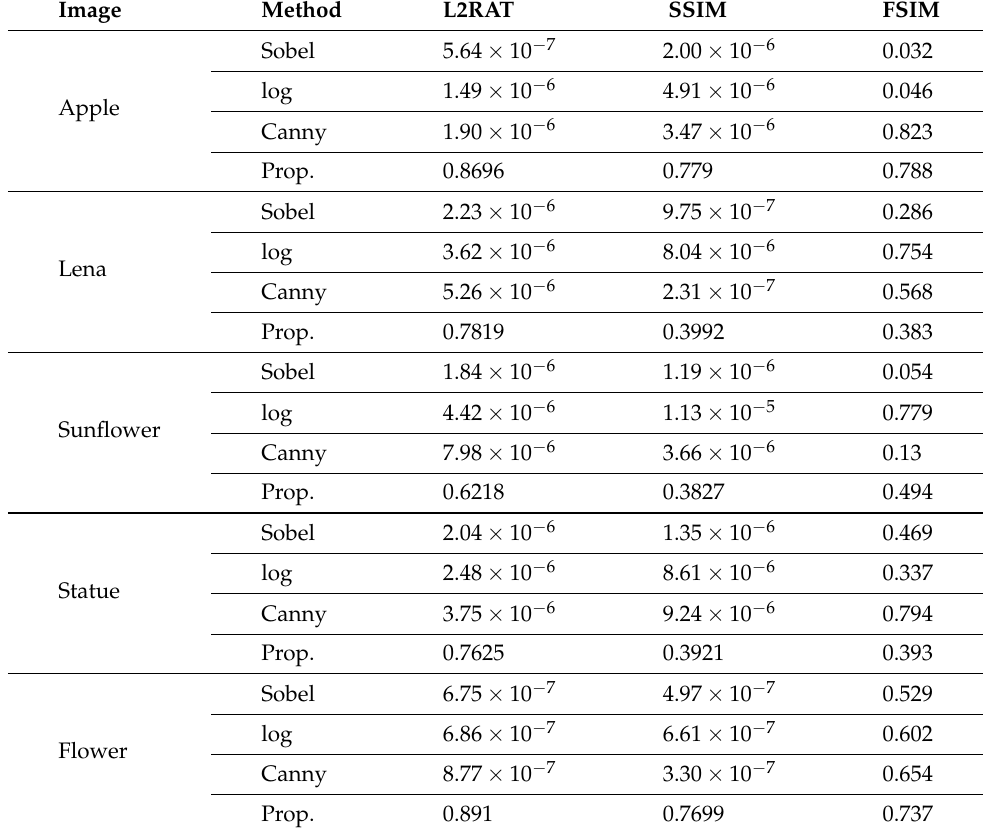
Table 3. Image quality assessment and